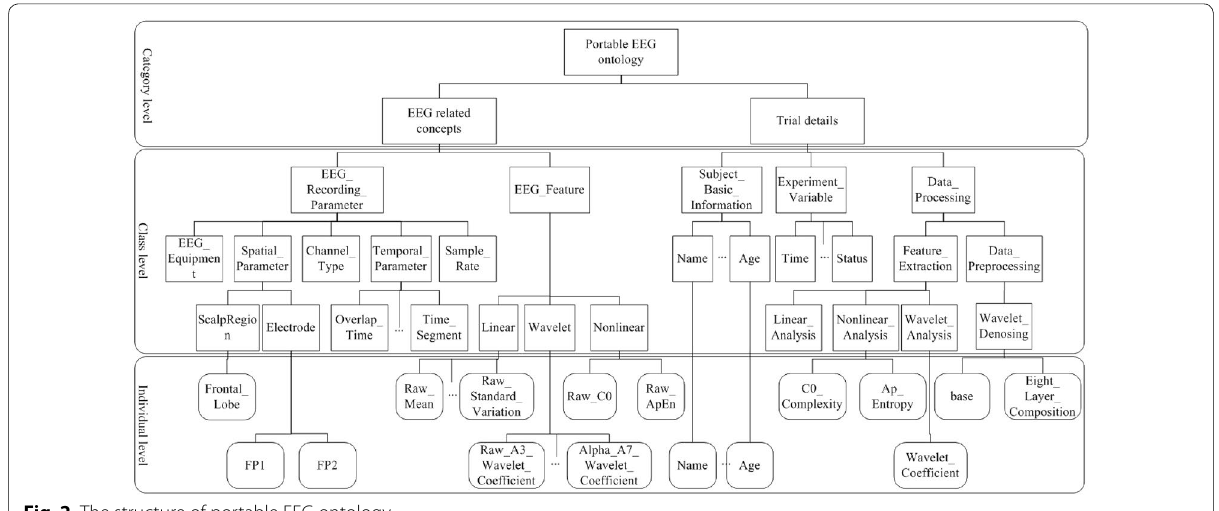
Fig. 2 The structure of portable EEG ontology